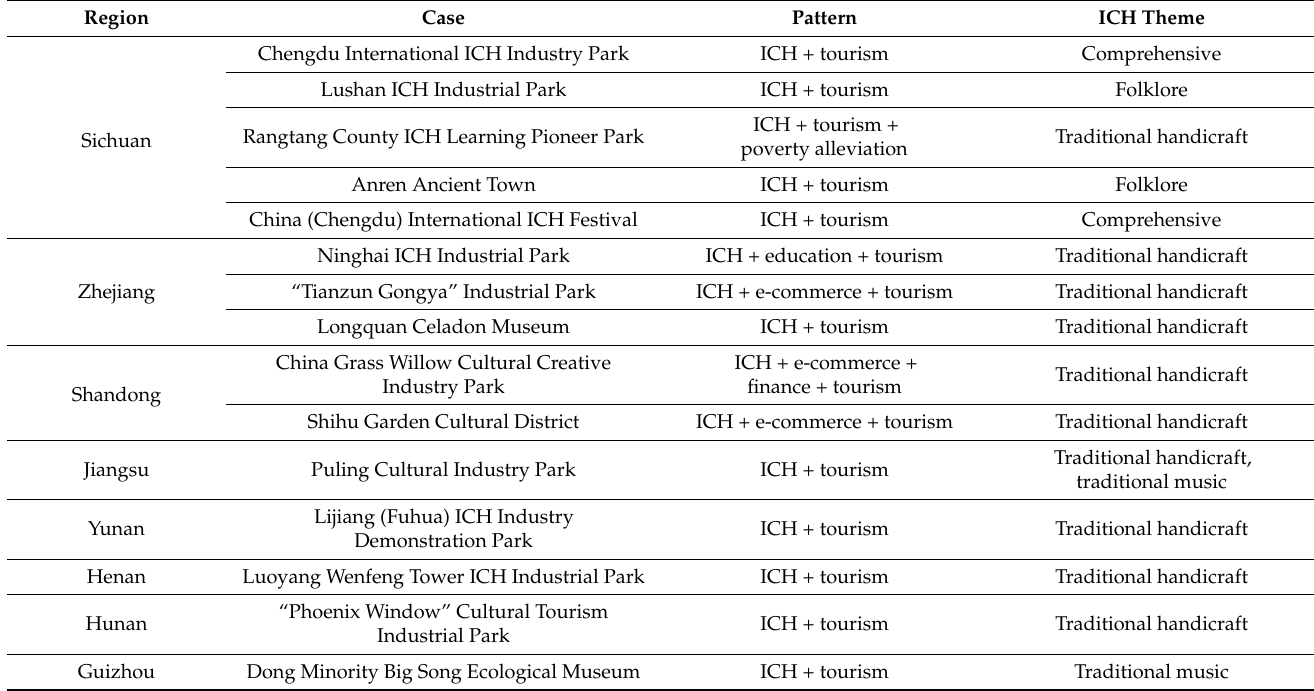
Table 1. Popular intangible cultural heritage (ICH) tourism patterns in China. Region Case